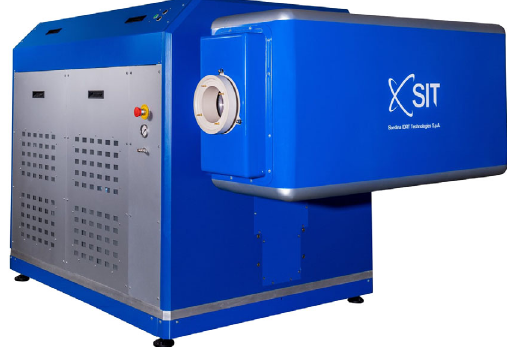
FIG. 17. Photograph of the ElectronFlash robotized system.